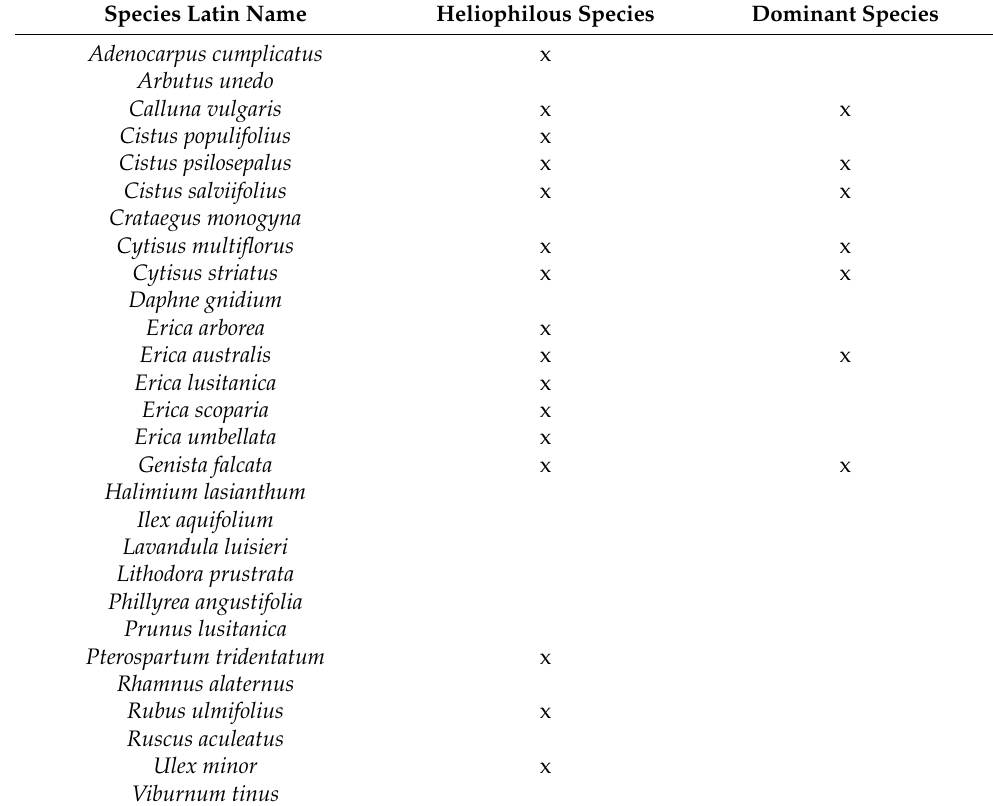
Table 1. Samples collected for the characterization